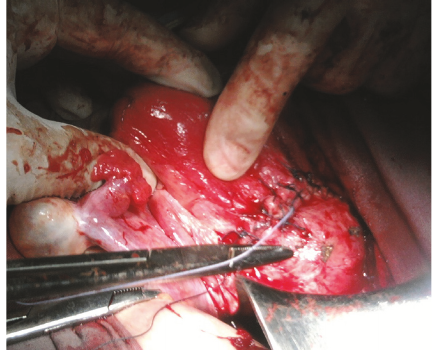
Figure 6: Operative view of the hysterorrhaphy after resection of the sac and its